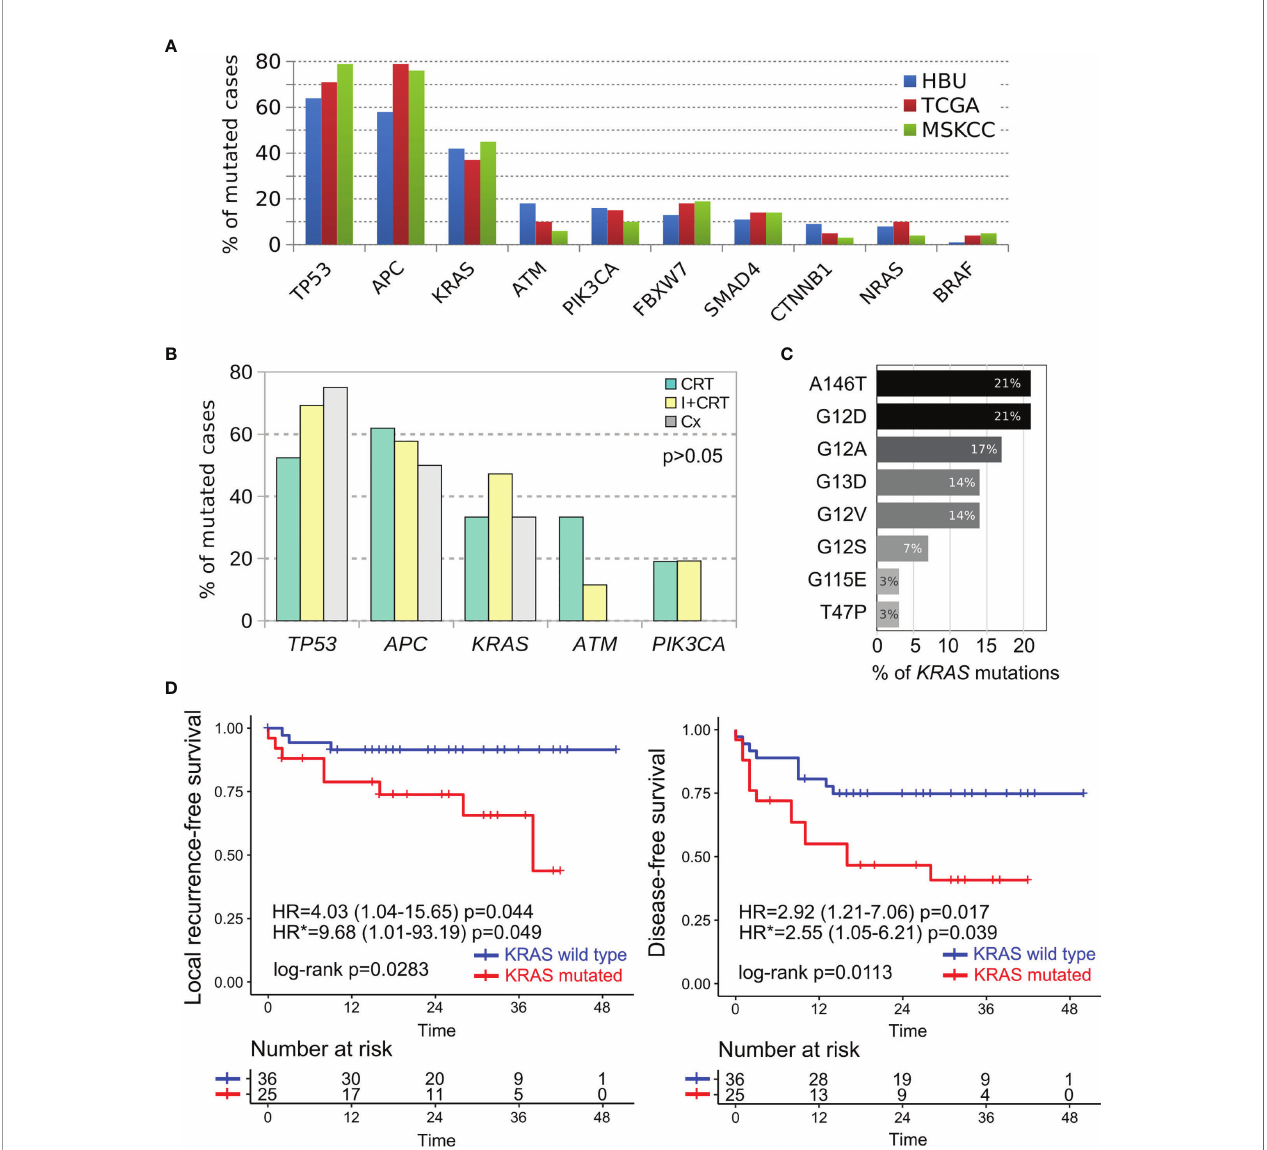
FIGURE 4 | Comparative mutational pro fi le of the most prevalent cancer driver genes in non-metastatic RC cases. (A) Comparative frequency of mutations in our non-metastatic cohort (HBU in blue bars), TCGA (red bars) and MSKCC (green bars) RC cohorts. (B) Comparative analysis of the most frequently mutated cancer driver genes according treatment assignment (CRT in green bars, I + CRT in yellows bars and TME upfront surgery in gray bars). (C) Most frequently KRAS missense mutations detected among RC cases. (D) Univariate Kaplan – Meier survival analysis and Cox regression analysis according the KRAS mutational status of RC cases. Survival analysis revealed that the KRAS mutated cases were particularly associated with shorter local recurrence-free survival and disease-free survival as showed by their hazard ratios determined in the univariate (HR) and multivariate (HR*)